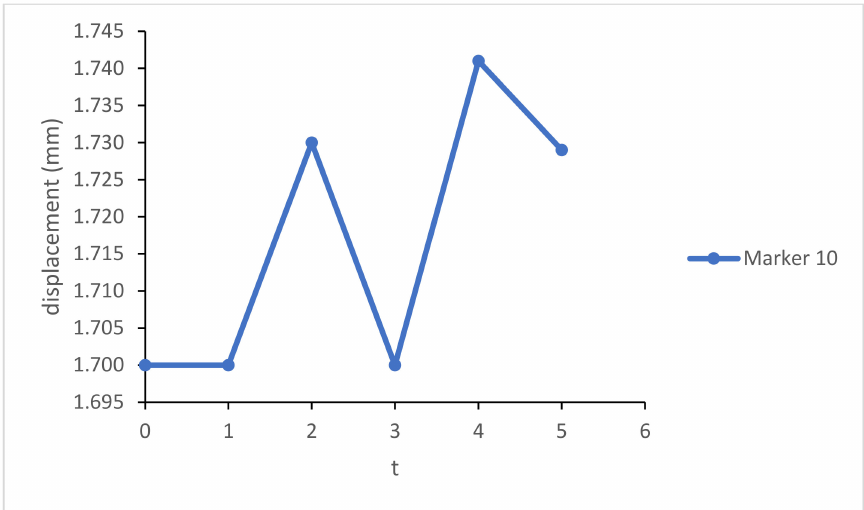
Figure 7. x coordinates of marker 10. Table 3. Corresponding eigenvectors of Y V Y T